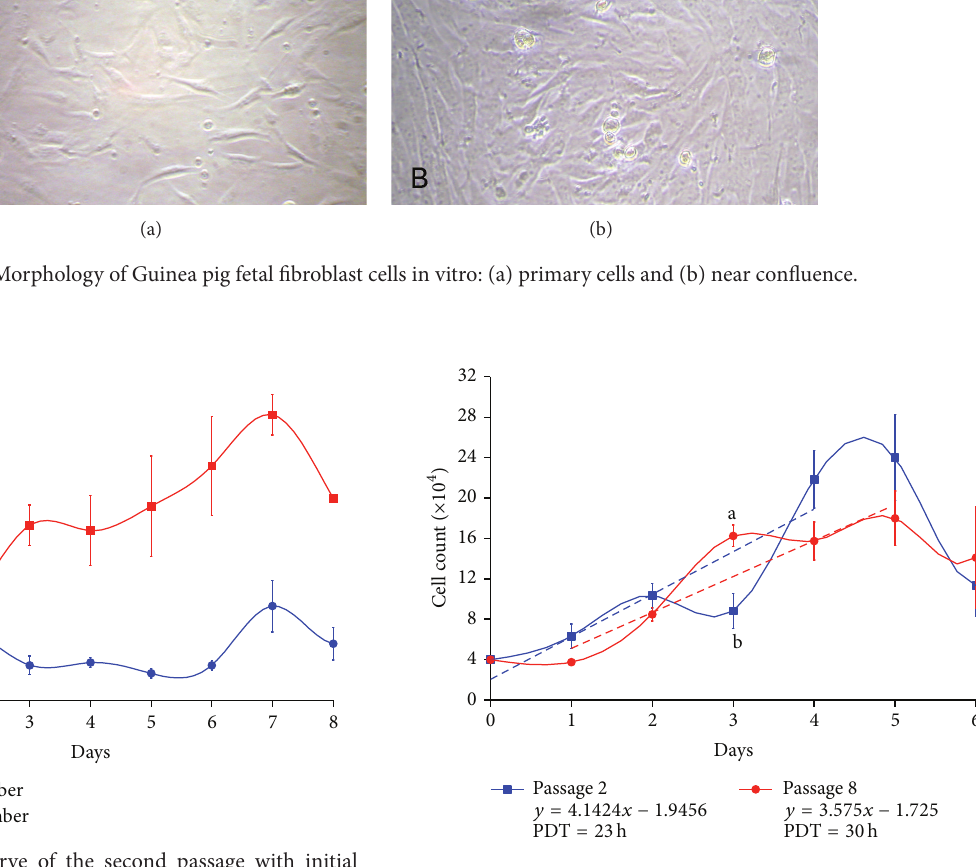
Figure 3: The growth curve and trend line equation of the second and eighth passages of the Guinea pig fetal fibroblast cells ( 𝑛 = 3 fetuses and 3 counted wells/day/fetus; mean ±